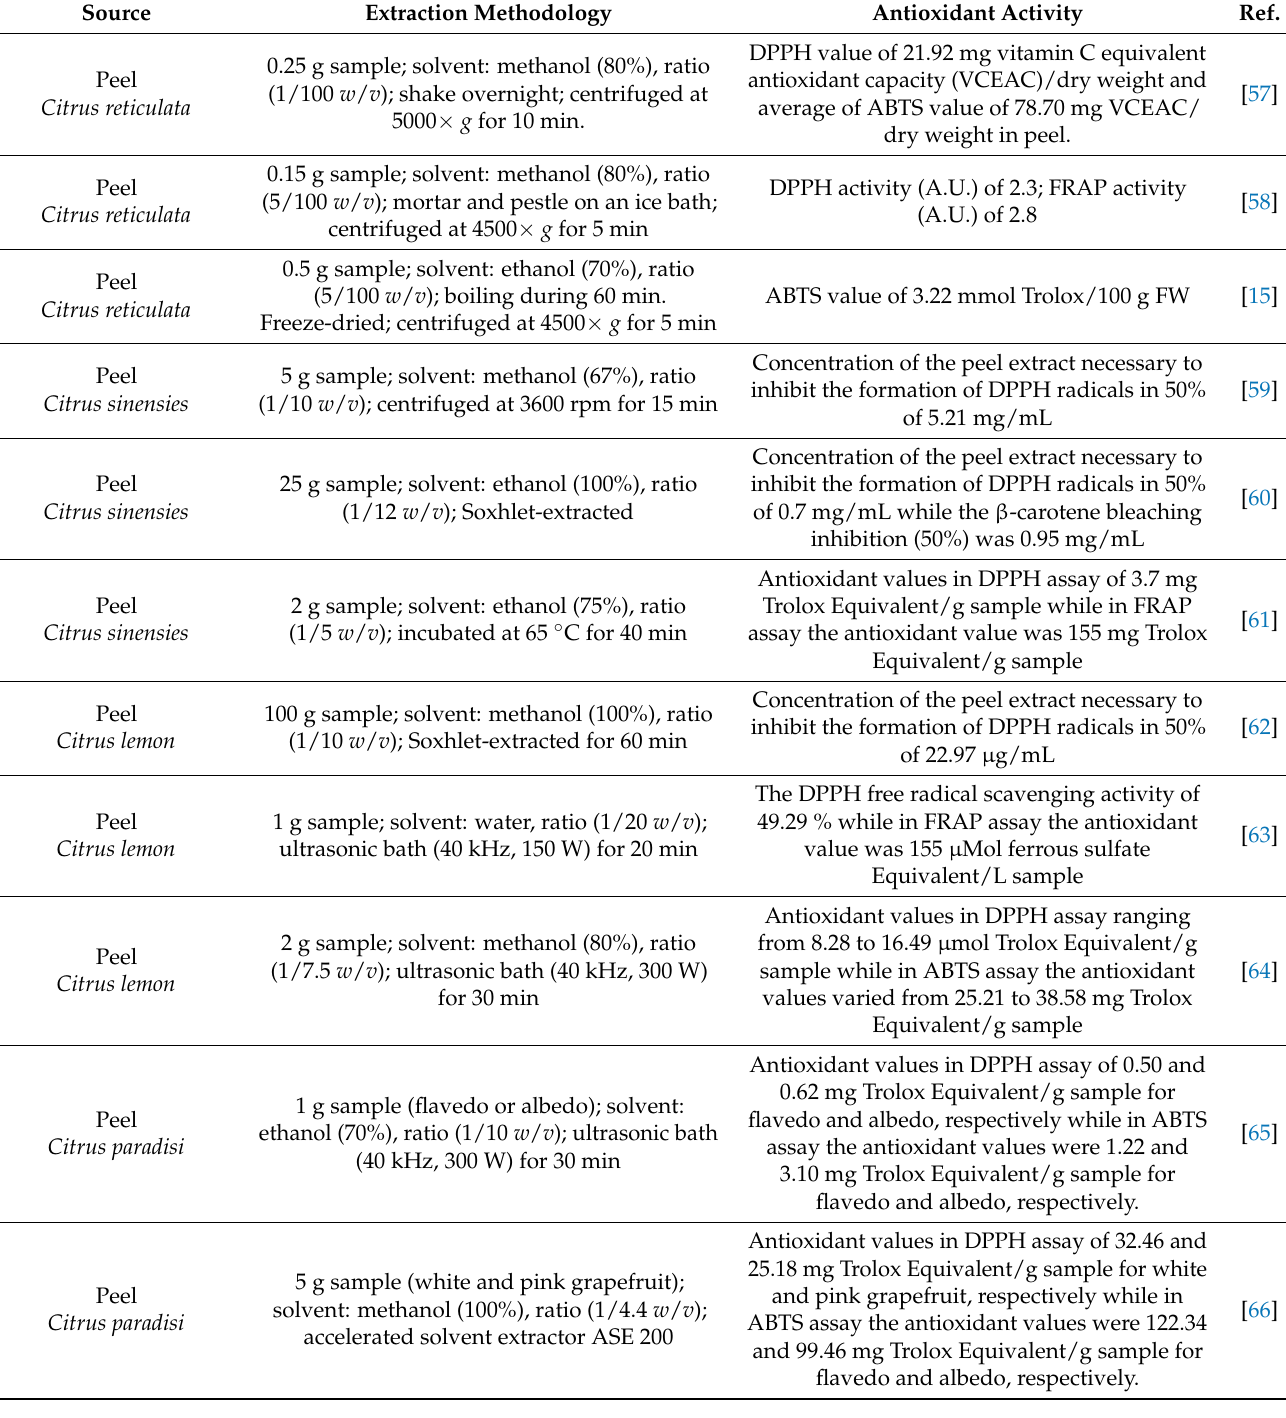
Table 1. Antioxidant activity of peel extracts obtained from different Citrus